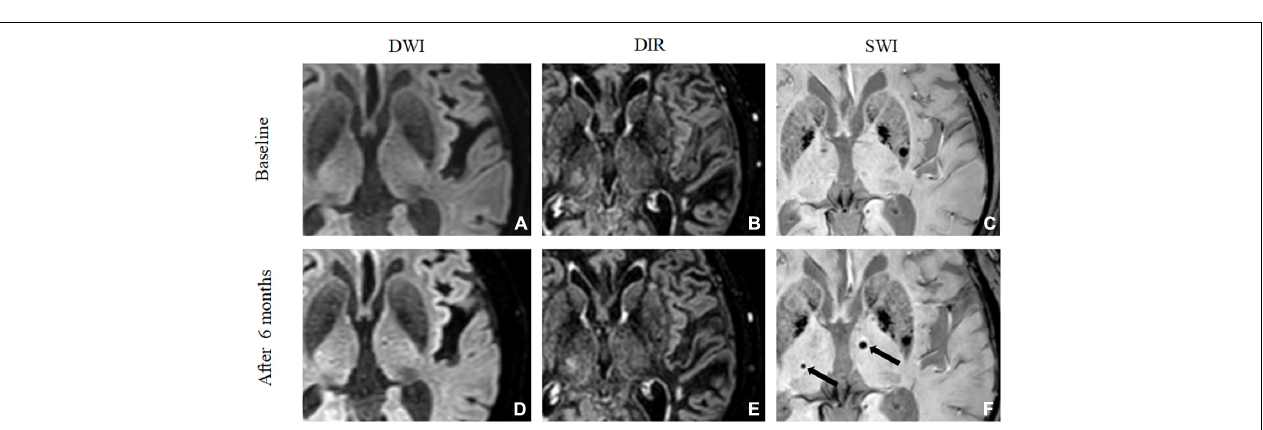
FIGURE 3 | De novo cerebral microbleeds mismatched with microinfarcts. A 73-year-old man showed no embolic microinfarct on DWI (A) or 3D-DIR (B) , and no CMBs were found on SWI (C) at baseline. After 6 months, DWI (D) and 3D-DIR (E) did not detect any abnormalities. Two de novo CMBs were detected in the bilateral thalamus by SWI (F) after 6 months, but the CMBs were not related to the microinfarction.